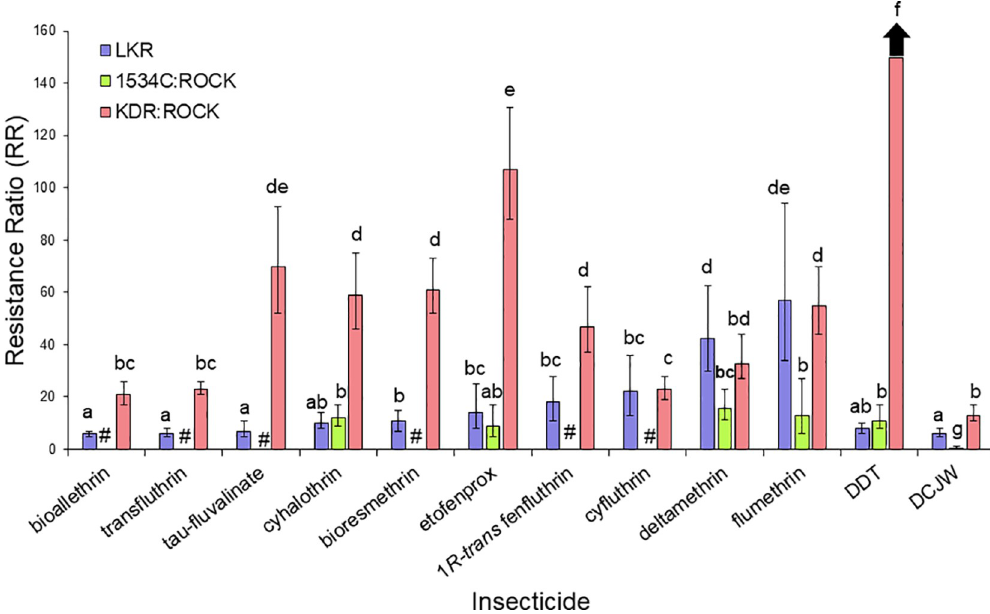
and 1 R-trans fenfluthrin) (Figs 4–7) were used. For these insecticides, resistance levels ranged from 6-fold (bioallethrin) to 57-fold (flumethrin) across the pyrethroids. There were no clear structural variations associated with higher or lower levels of resistance. LKR was also resistant to DCJW (6-fold) and DDT (8-fold). To evaluate the role of stereochemistry in the levels of